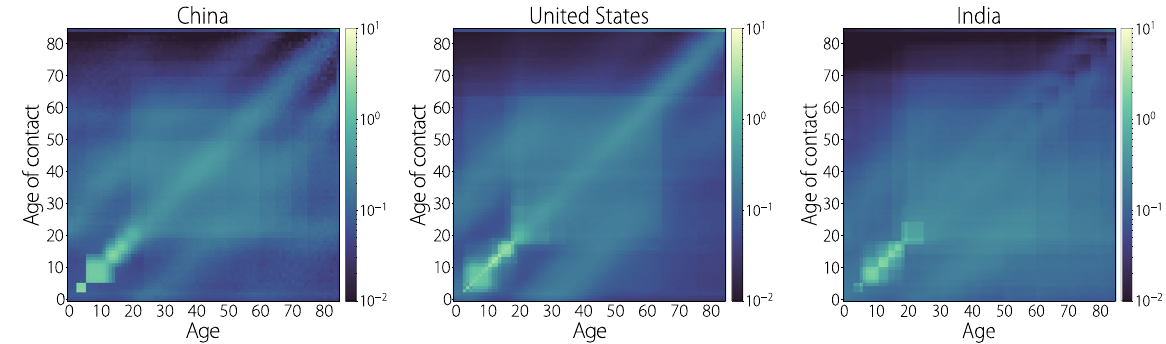
Fig. 4 Overall contact matrices. Each heatmap represents the overall average number of contacts relevant for airborne infectious disease transmission by age at the national level for China, the United States, and India.